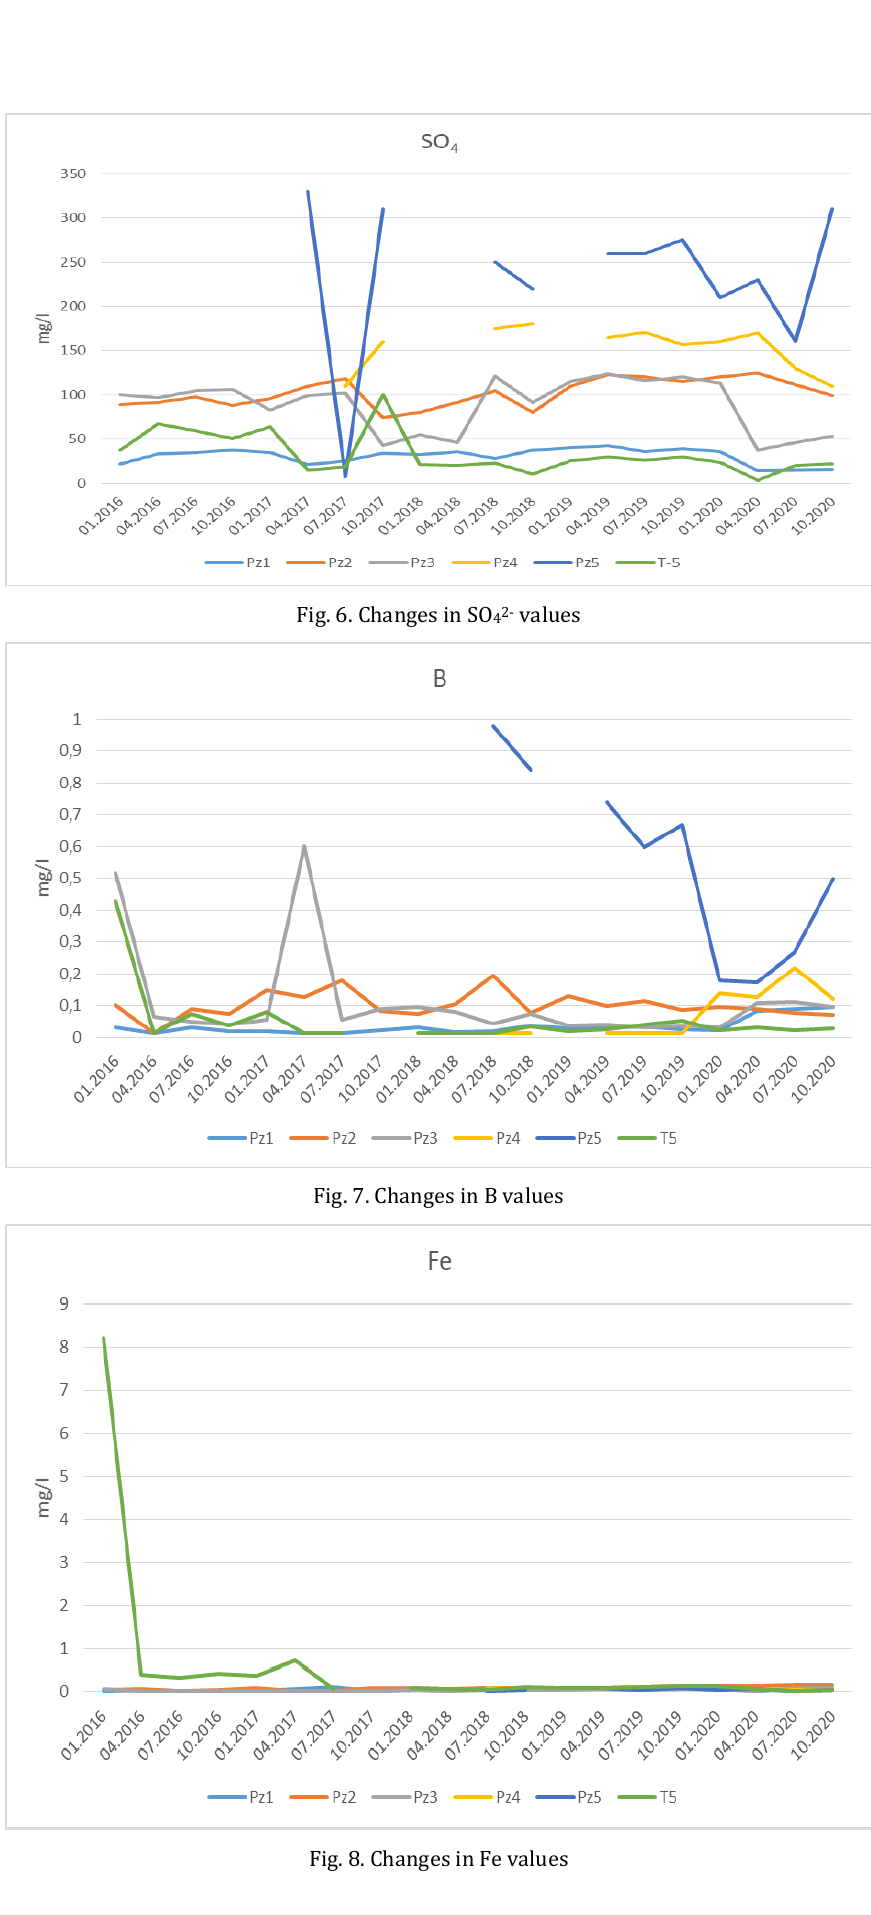
Fig. 8. Changes in Fe